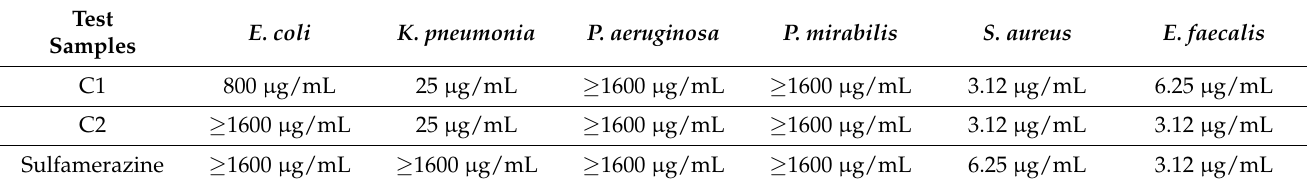
Table 1. Antimicrobial activities of components.